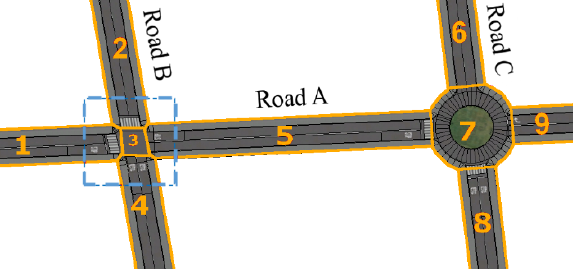
Figure 6. Illustration of road